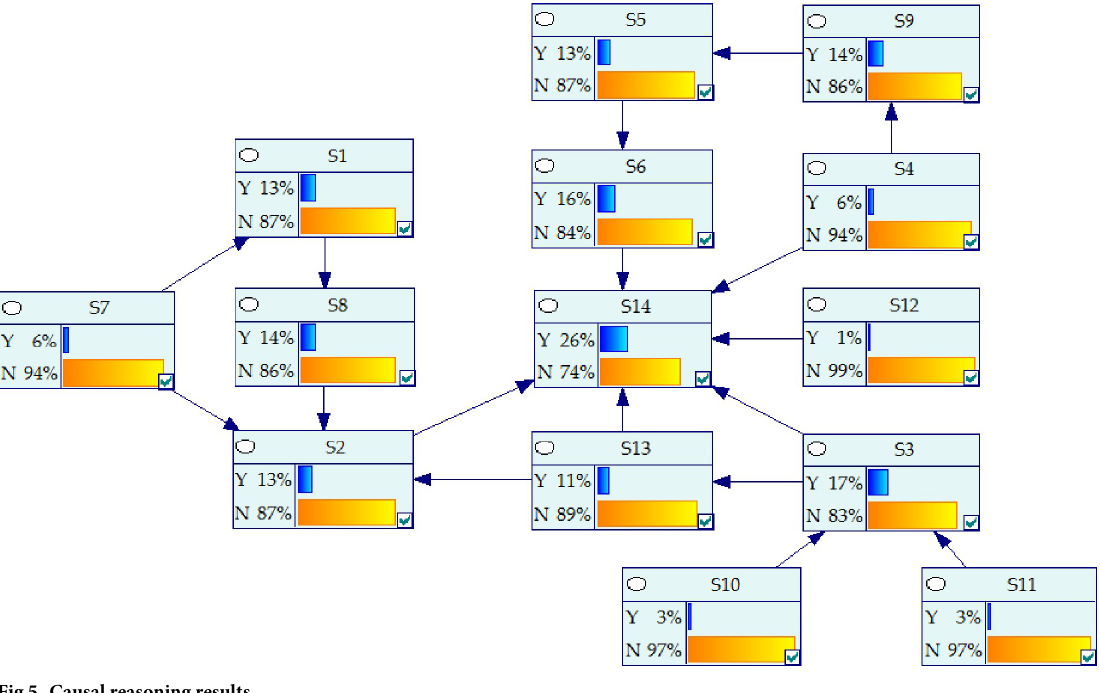
Fig 5. Causal reasoning